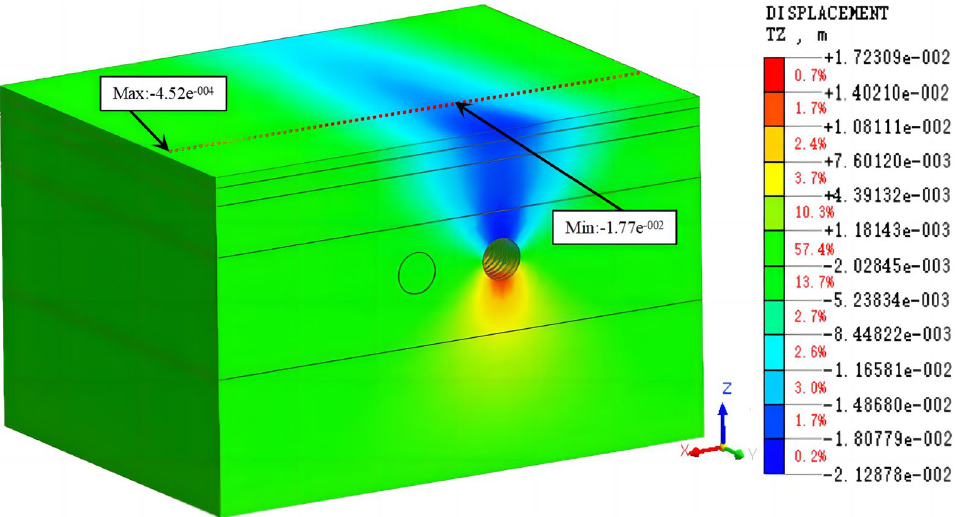
Figure 9. The cloud diagram of the vertical displacement for working condition 1 (excavation of the left